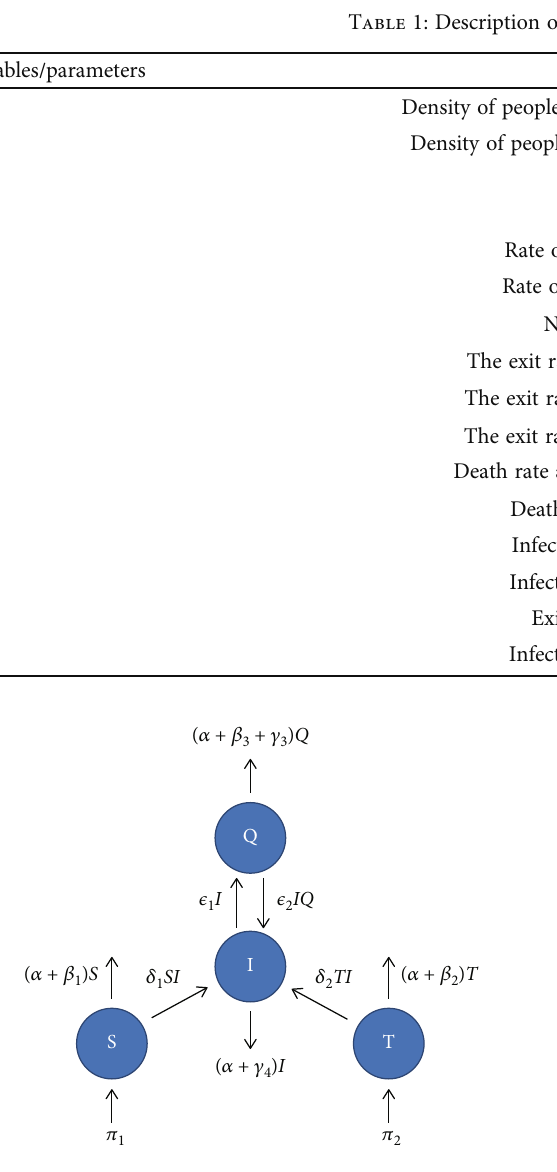
Figure 1: Smoking